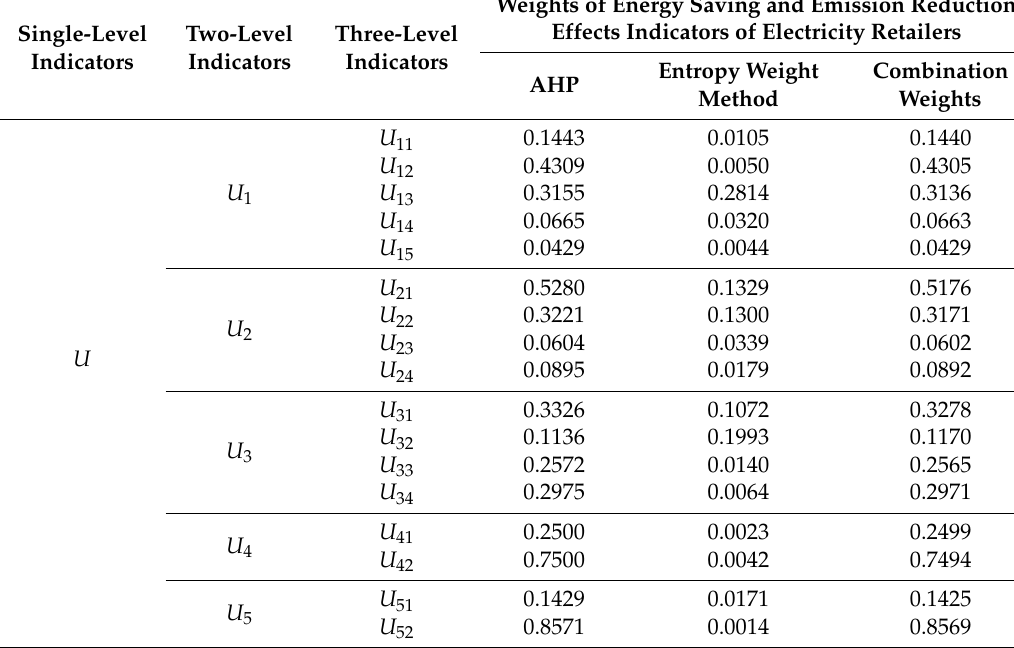
Table 7. Combination weights of energy saving and emission reduction effects evaluation indicators of electricity